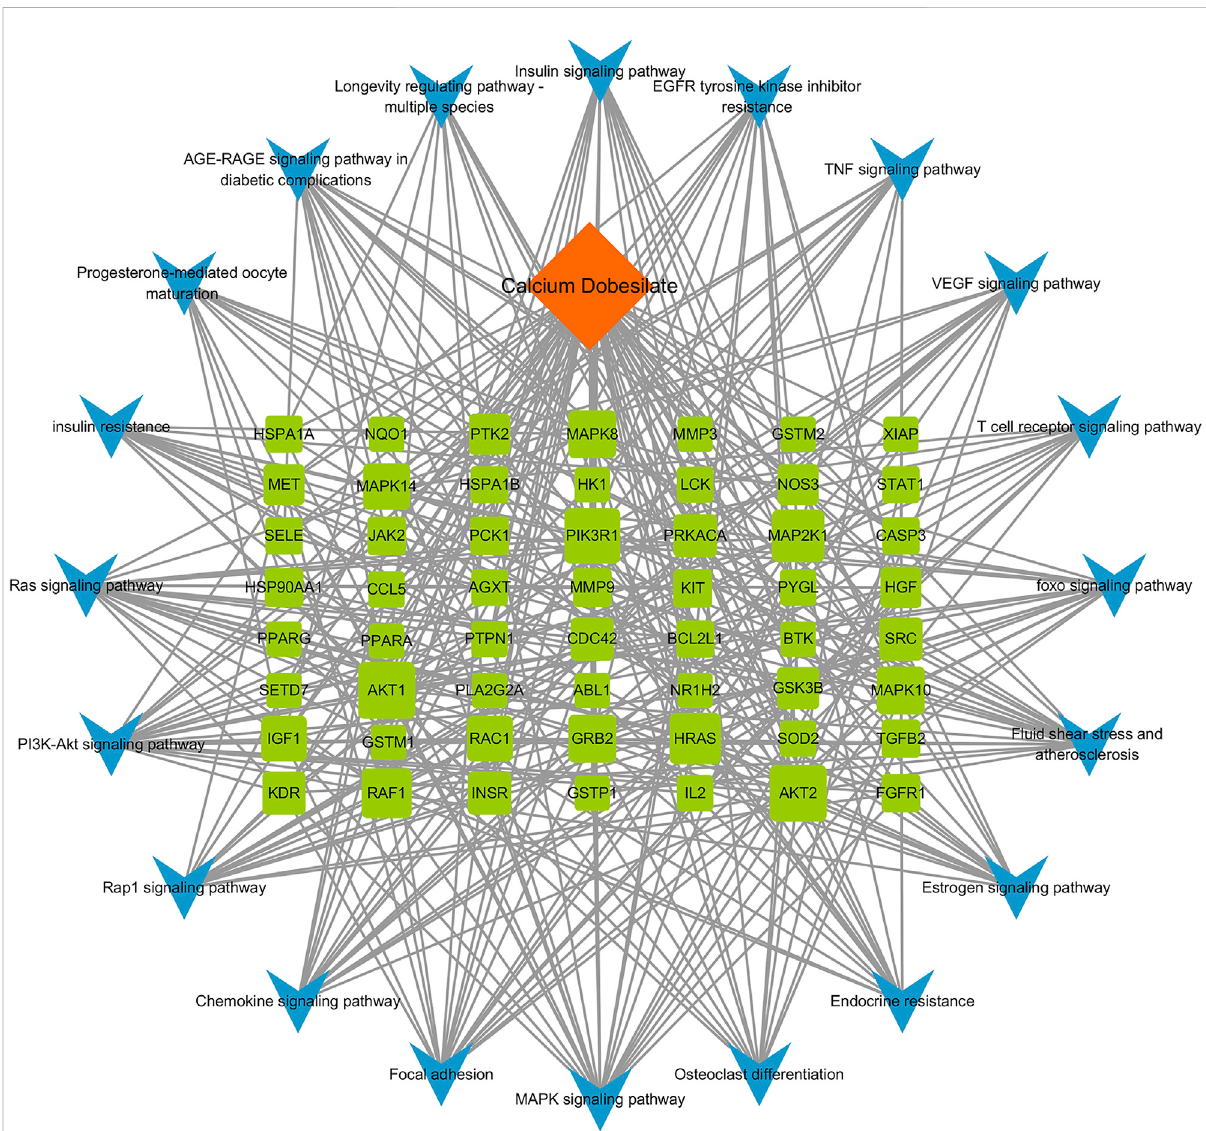
FIGURE 5 Component – target – pathwaynetwork.Atotalof77nodesand372edgesarepresentinthenetwork.Orangediamondrepresentsthebioactive component of CaD, 57 green squares represent targets, and 20 blue V-shapes represent pathways. Sizes of the green square node are illustrated from big to small in a descending order of degree values. A total of 372 edges represent the interaction relationship between components, targets, and